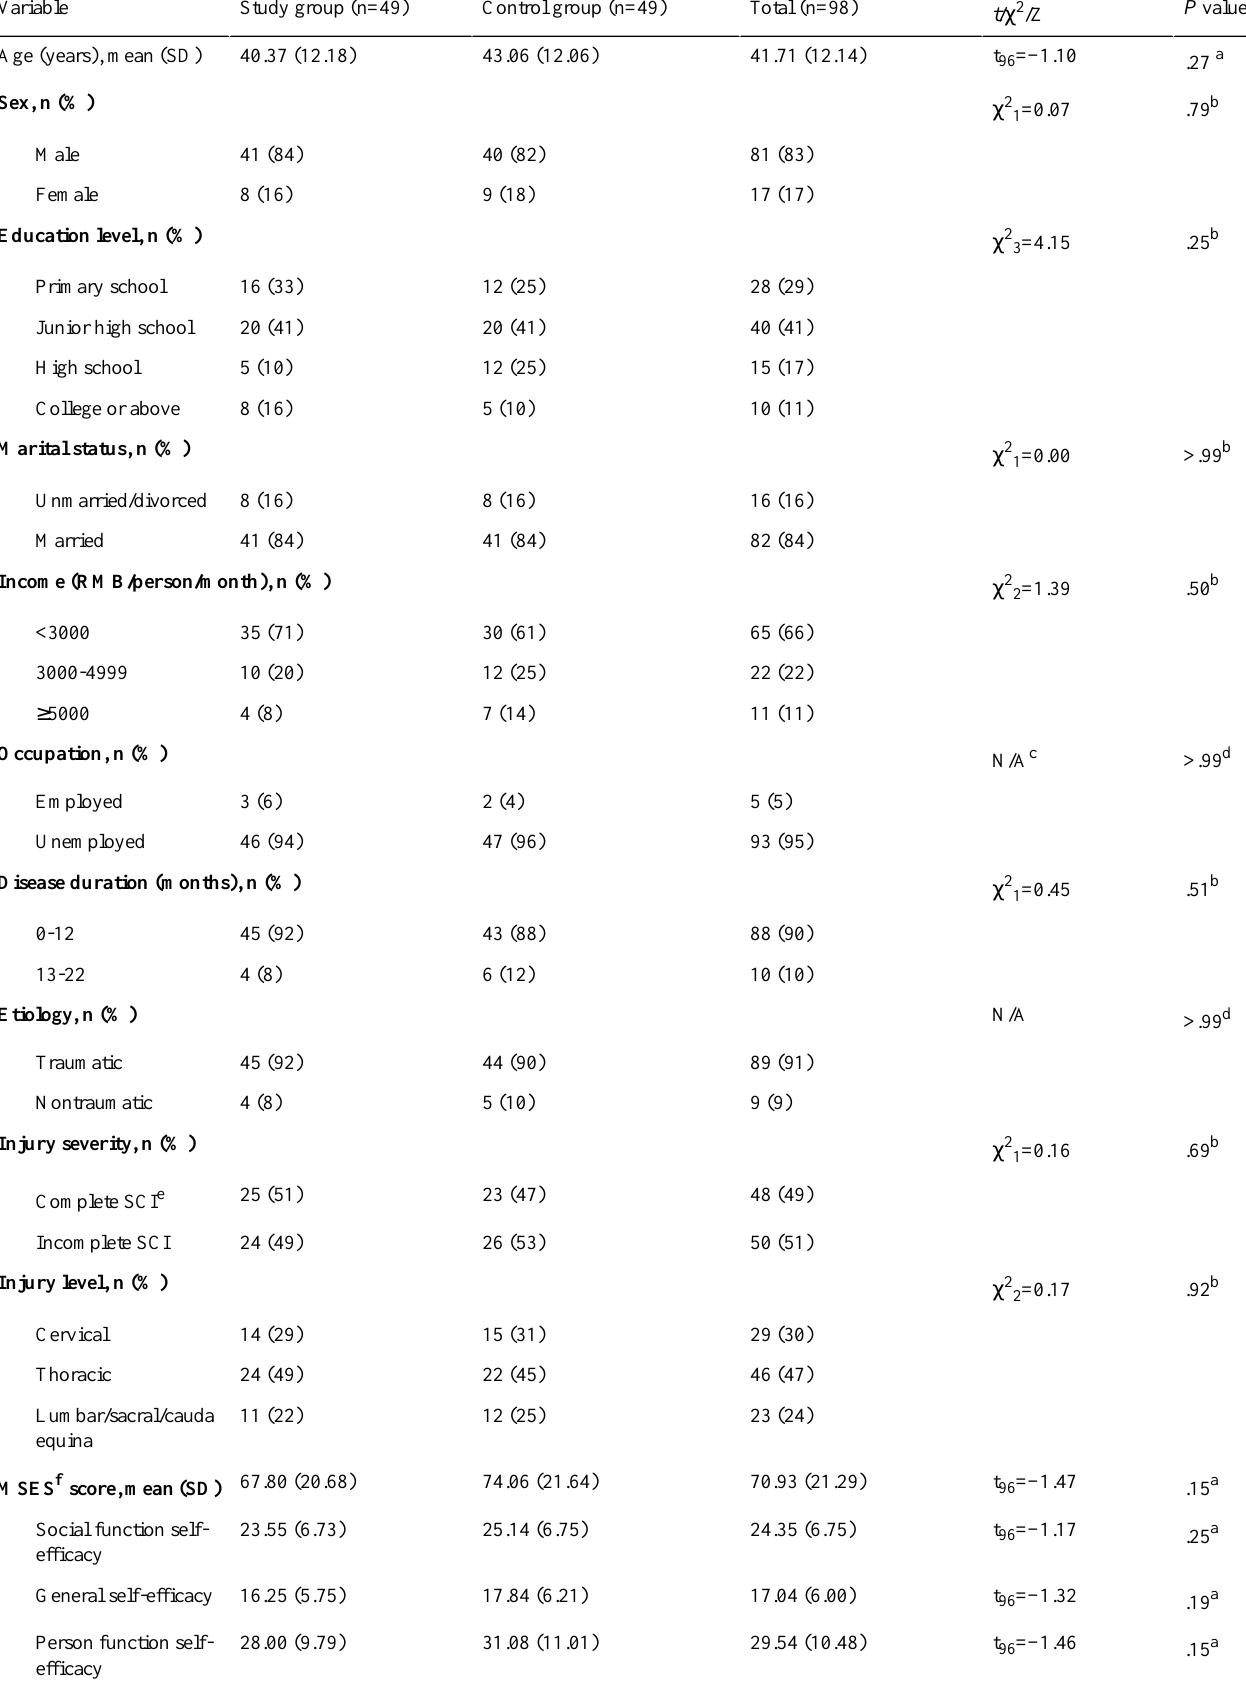
Table 3. Balance test between the study and control